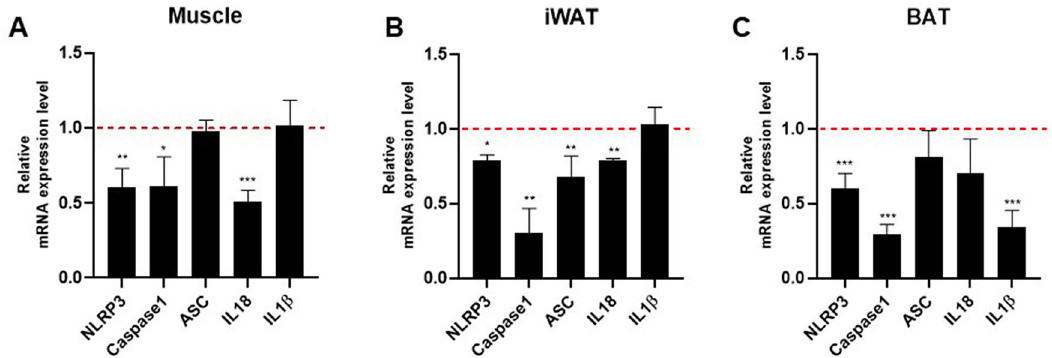
Figure 8. Effect of NAG-1 on the mRNA expression level of NLRP3 inflammasome components. The mRNA expression levels of Nlrp3 , Casp1 , Asc , Il-18 , and Il-1b in the ( A ) muscle, ( B ) inguinal white adipose tissue, and ( C ) brown adipose tissue. The expression levels of target genes were normalized to those of Gapdh . Data are presented as mean ± standard error of mean and were analyzed using the Student’s t -test. *p < 0.05, **p < 0.01, and ***p < 0.001, compared with the control group (n =